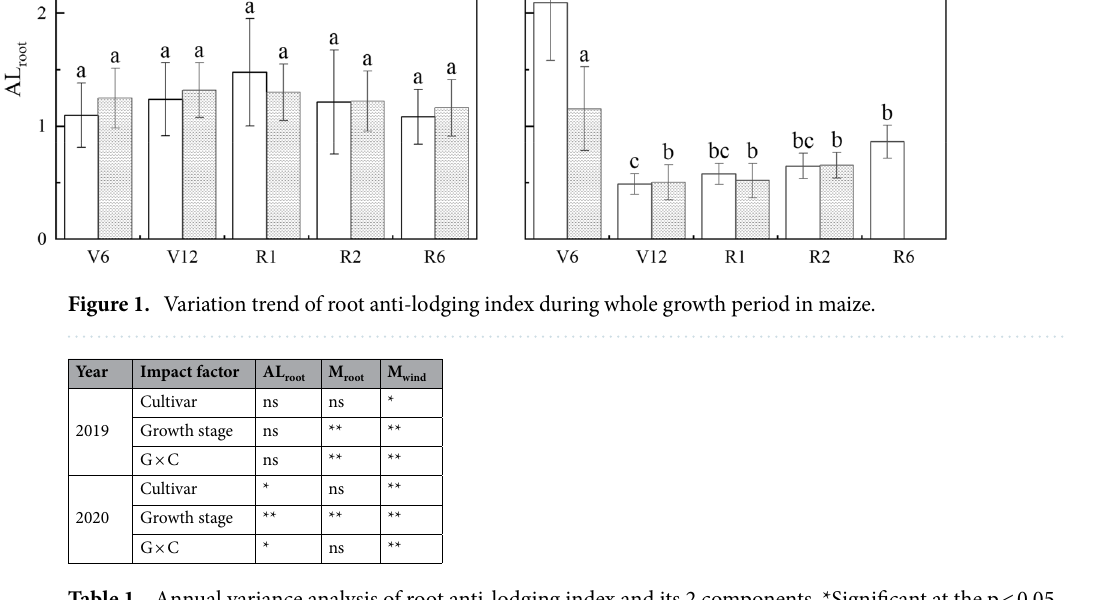
Table 1. Annual variance analysis of root anti-lodging index and its 2 components. *Significant at the p < 0.05 level. **Significant at the p < 0.01 level; ns denotes no significant